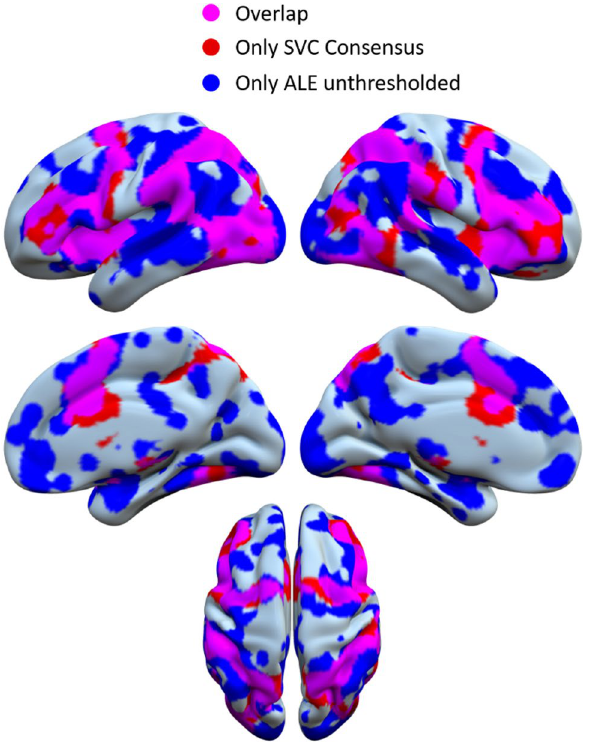
Figure 4. Surface map showing the overlap between the results of the unthresholded ALE (blue) and the SVC Consensus (red) analyses, for General Prediction. The overlapping regions are presented in purple.